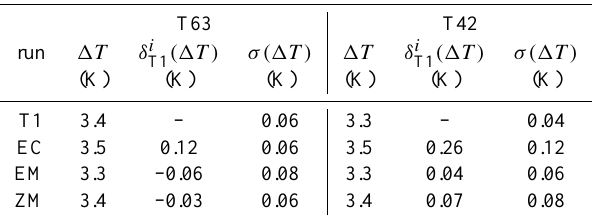
Table 2. Calculated temperature increase 1T , inter-annual variabil- ity σ (one standard deviation) and temperature difference δ for the lowermost model layer (horizontally area weighted) with T1 as the reference